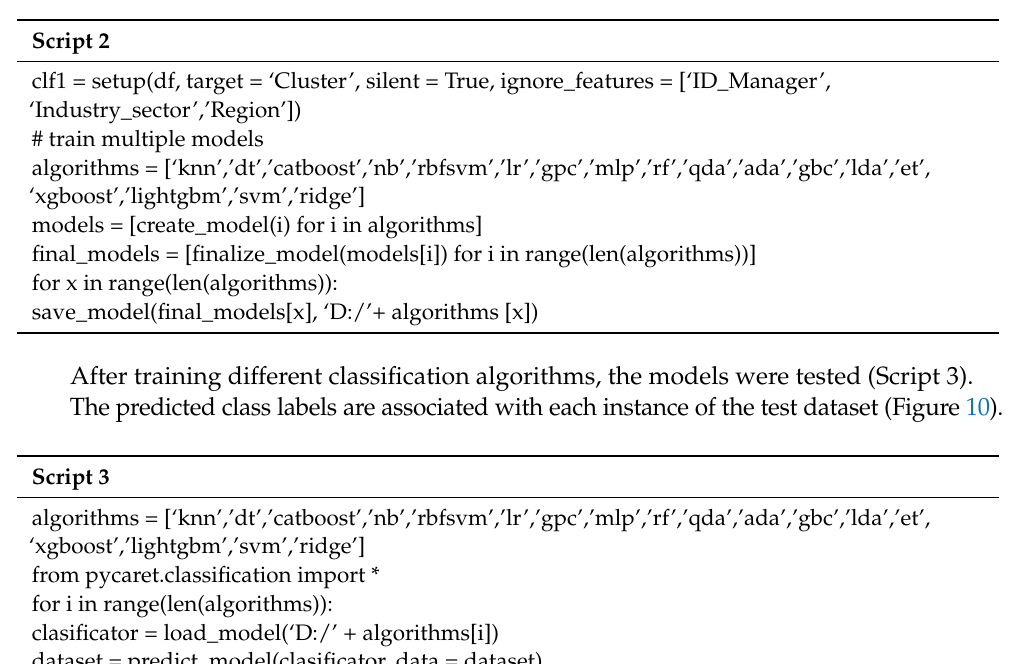
Figure 9. O31. Labelled dataset. Partial data